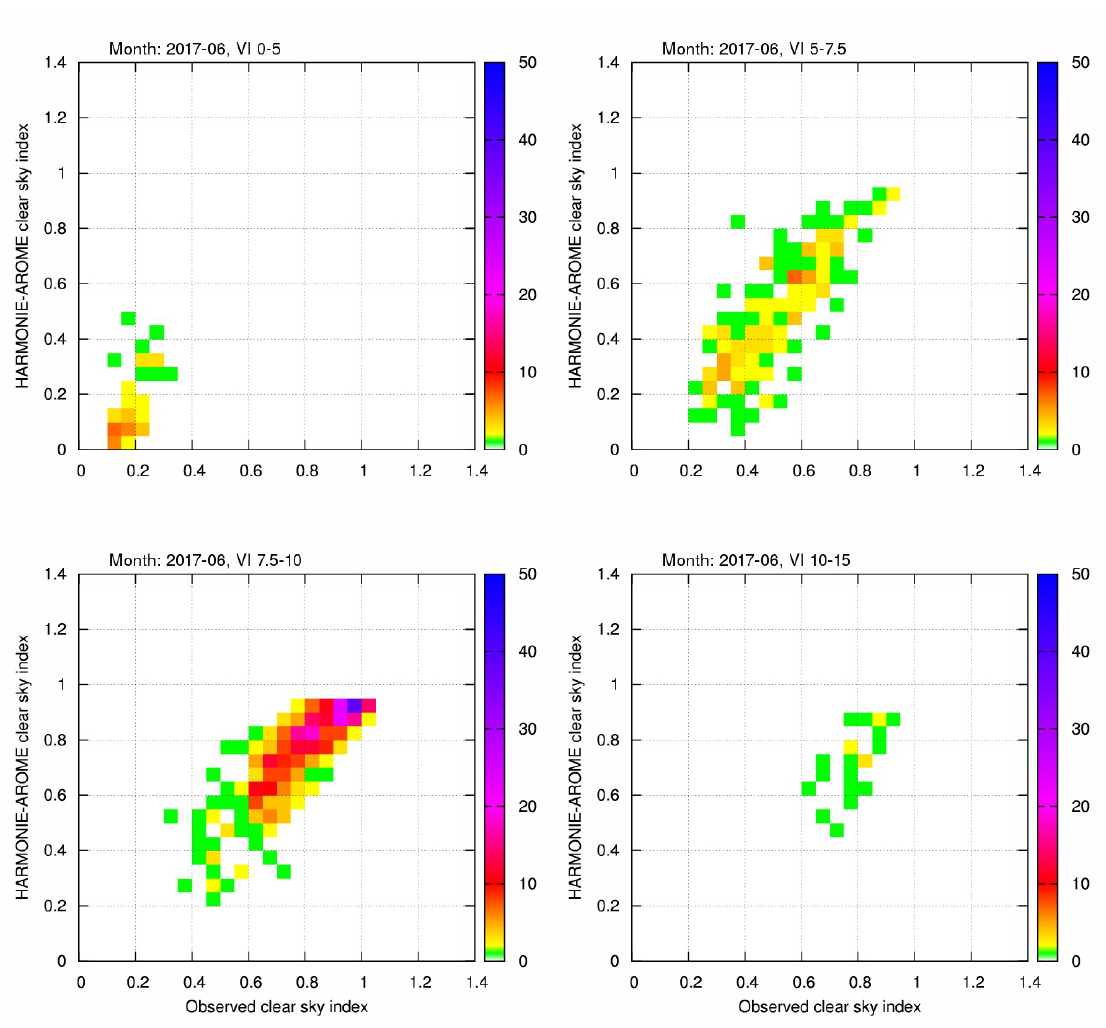
Figure 15. 2D histograms of the binned Danish HARMONIE-AROME NEA CSI values as a function of the observed CSI values for the month of June 2017. The results are divided into four VI bins with the ranges: upper left , VI 0 to 5; upper right , VI 5 to 7.5; lower left , VI 7.5 to 10; lower right , VI 10 to